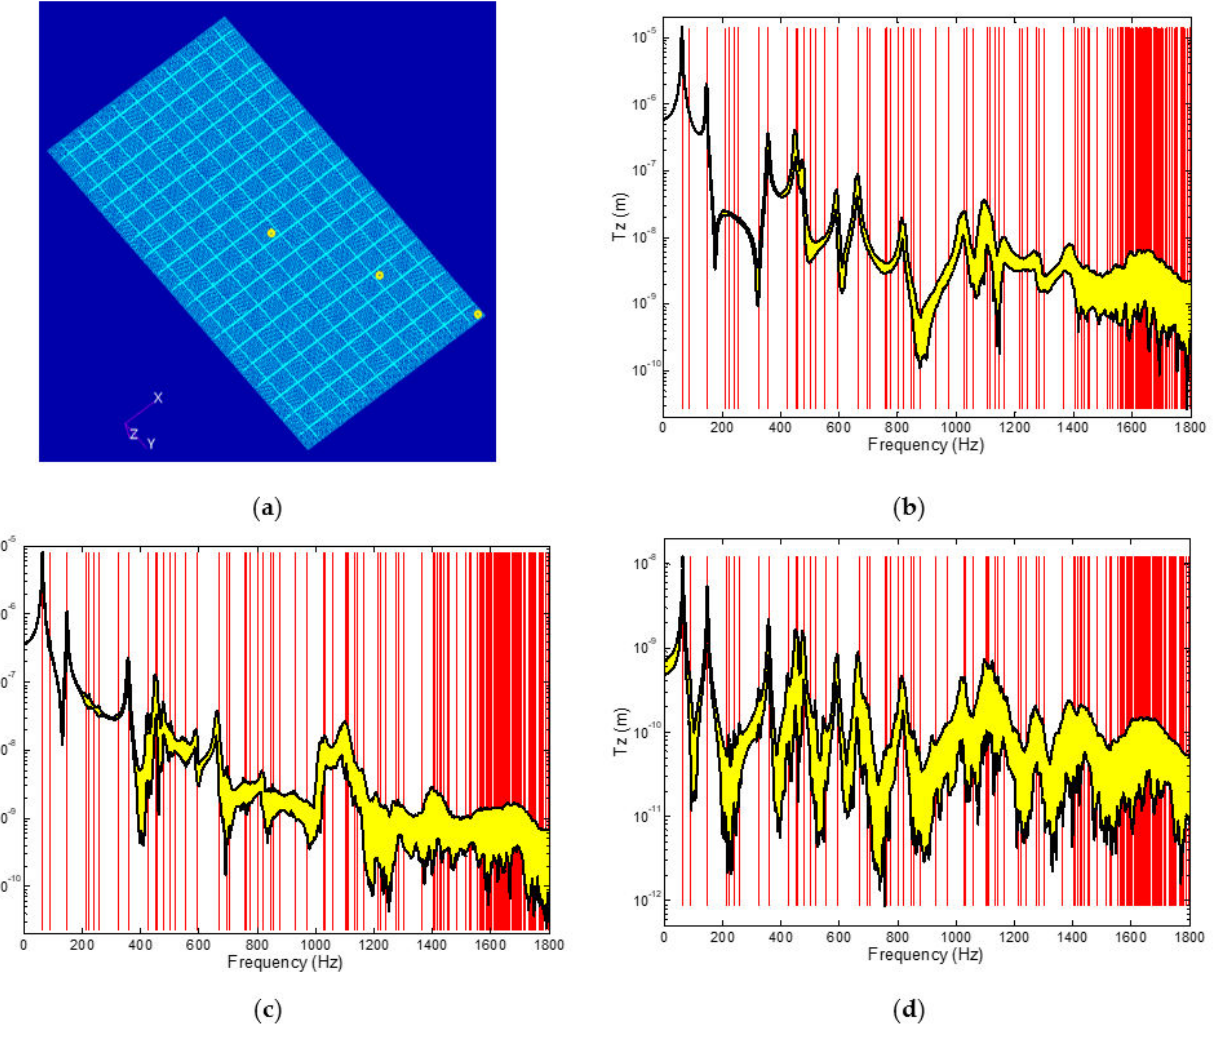
Figure 11. Uncertainty band (in yellow) of linear frequency responses of the random linear ROM samples to uniform pressure load. ( a ) Three locations on the panel where the uncertainty band results are shown; ( b ) center point, ( c ) quarter point, and ( d ) edge point. The red lines indicate the natural frequencies of the deterministic